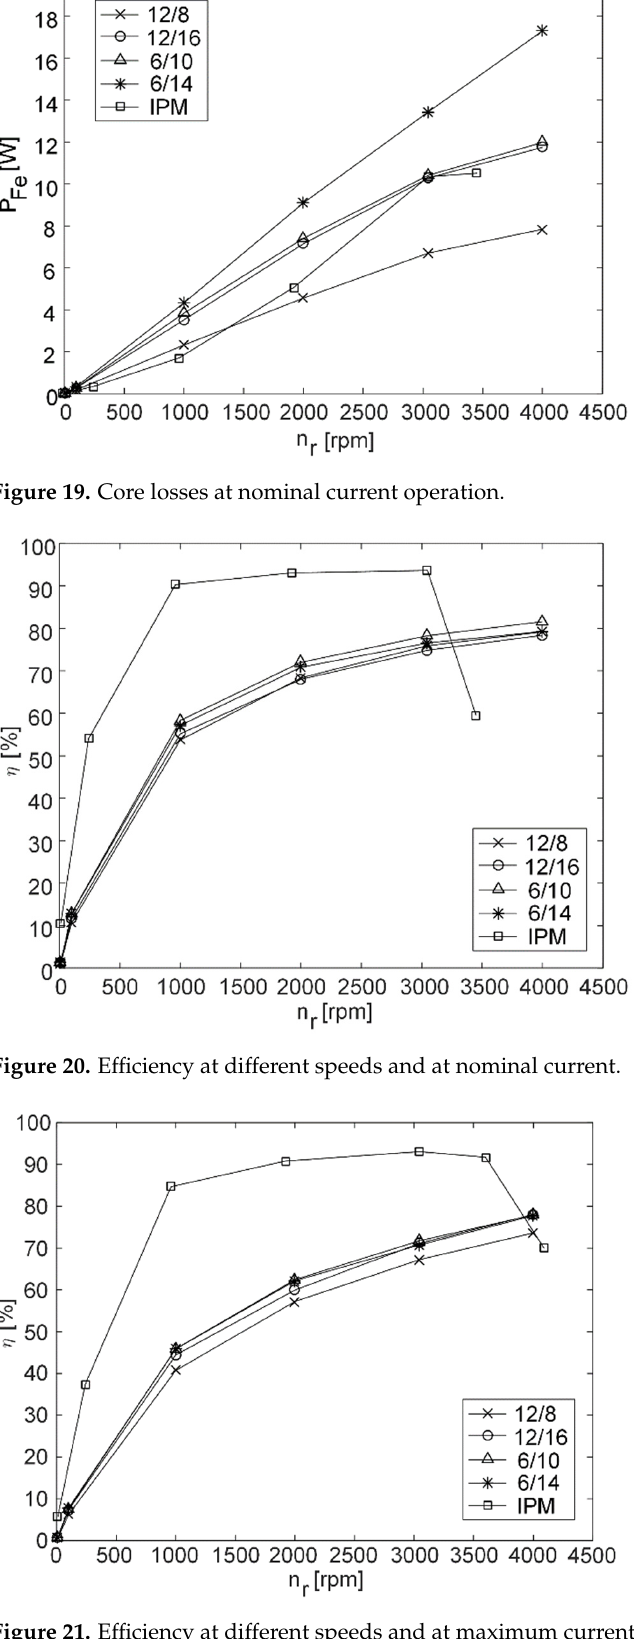
Figure 22. Maximum temperature in the motor after 1h operation at nominal current for different SRM configurations. Figure 23. Maximum temperature in the motor after 100s operation at maximum current for differ- ent SRM configurations.